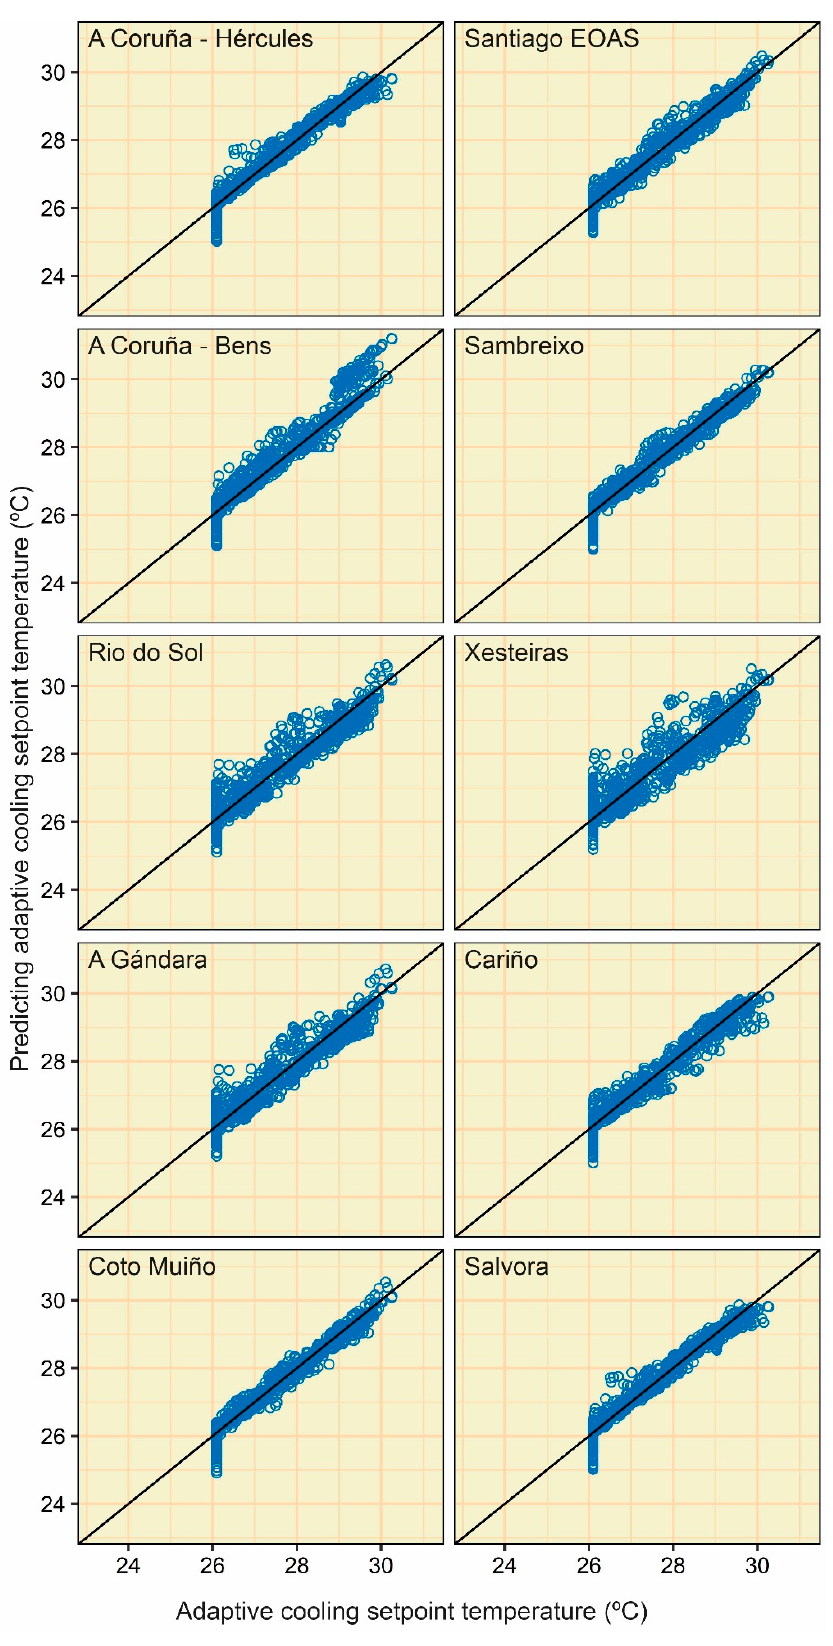
Figure A9. Point clouds between the actual and predicting adaptive cooling setpoint temperature values (category III) of the MLR (approach 2).